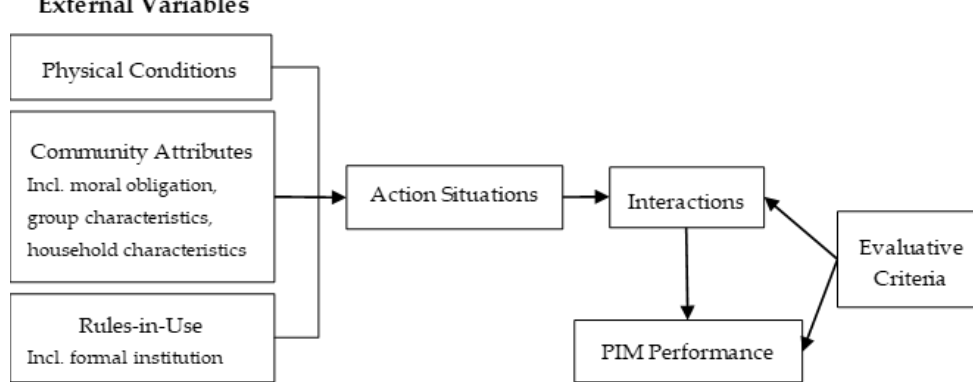
Figure 1. Theoretical framework for analyzing the influence of factors on PIM performance. Source: Adapted from Ostrom [50].